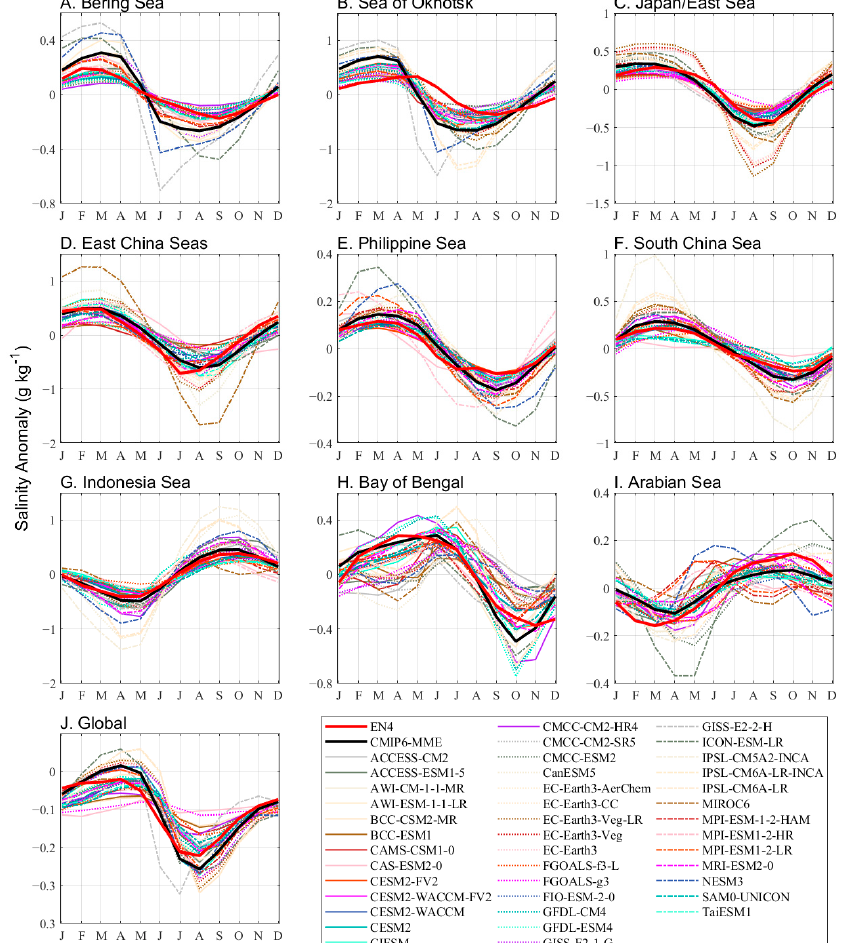
Figure 6. Spatial mean seasonal variation of the sea surface salinity (SSS) of each part of the Asian Marginal Seas ( A – I ) and global mean SSS ( J ) in the observations and the CMIP6 models. The salinity anomalies are relative to the annual average. The red and black solid contours indicate the observations and CMIP6 multi-model ensemble means, respectively.